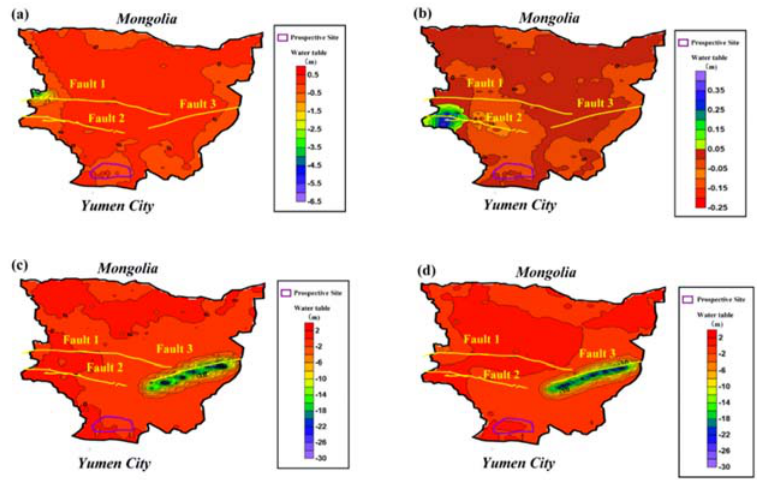
Figure 13. Contour map of the water table difference in the scenarios relative to the base case: ( a ) water table difference between S2 and S1; ( b ) water table difference between S3 and S1; ( c ) water table difference between S4 and S1; and ( d ) water table difference between S5 and S1.